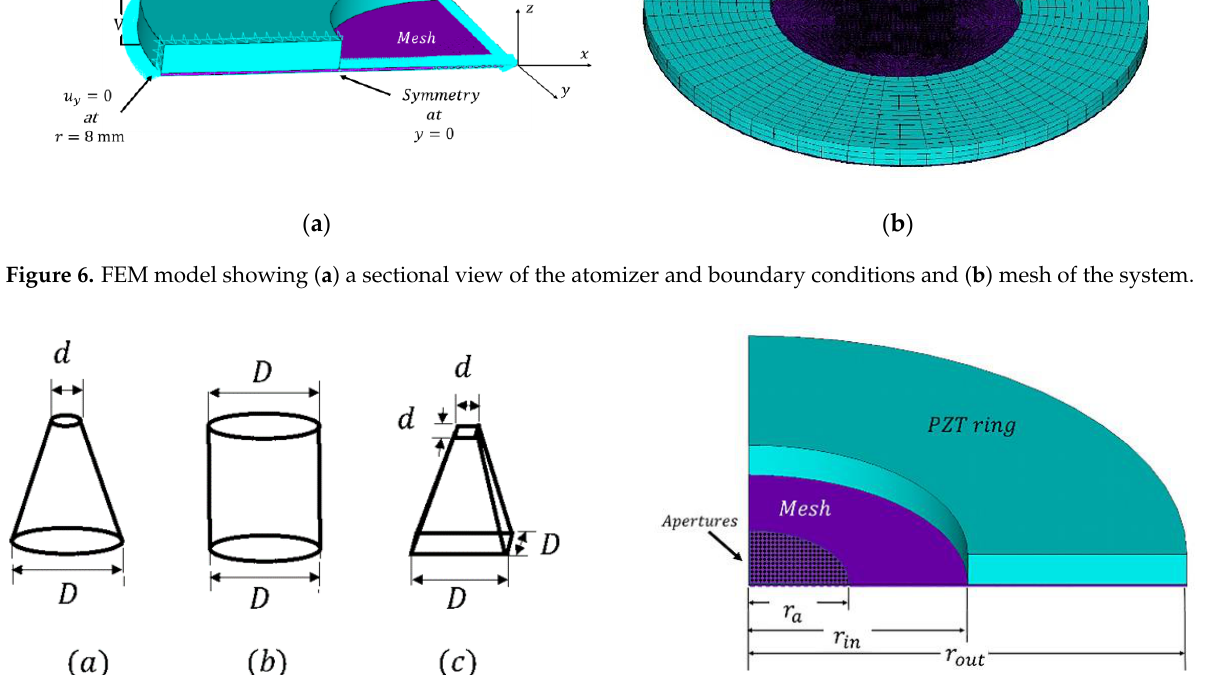
Figure 8. Displacement against the voltage amplitude.